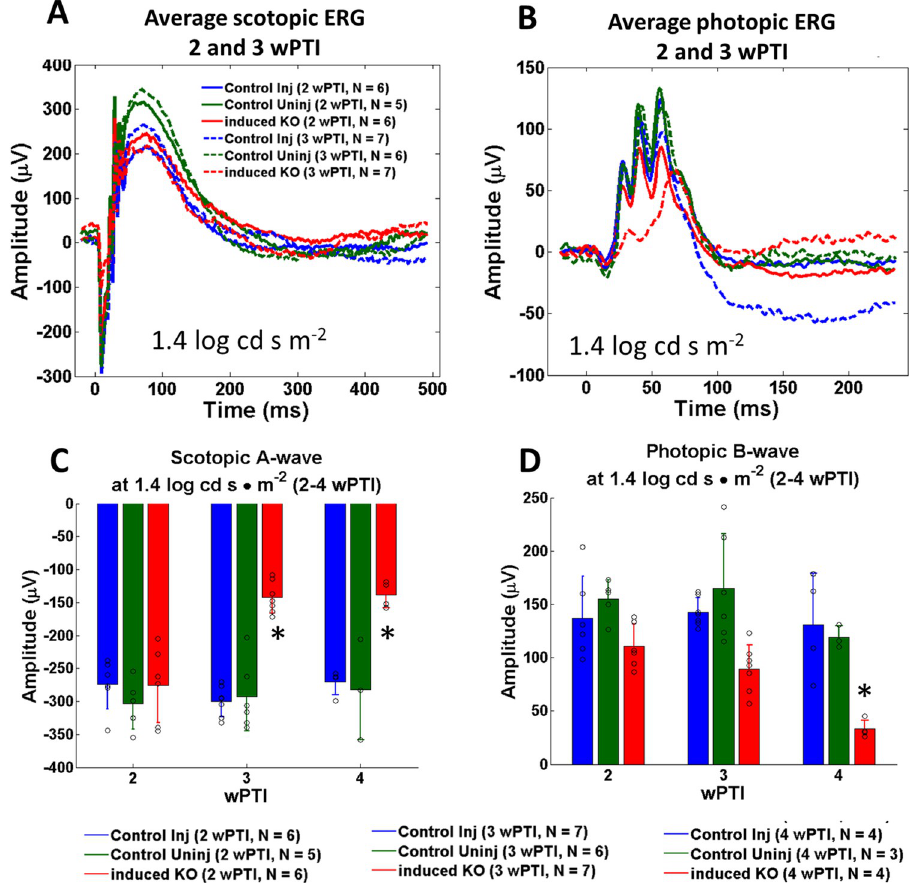
Fig 11. Electroretinography of control and tam Cep164 -/- mice. A, B , average scotopic (A) and photopic ERG (B) at 1.4 log cd s m -2 . 2wPTI is shown in solid traces, and 3wPTI in hatched traces. Control-injected traces (blue), control- uninjected traces (green), tam Cep164 -/- (red). Traces are averaged with N = 5–7. C, D , statistical evaluation of scotopic a-waves (C) and photopic b-wave amplitudes (D) at 2wPTI, 3wPTI and 4wPTI at 1.4 log cd s/m 2 . Colors as in A and B, number of animals (N) used is shown at the bottom. � p < 0.05,